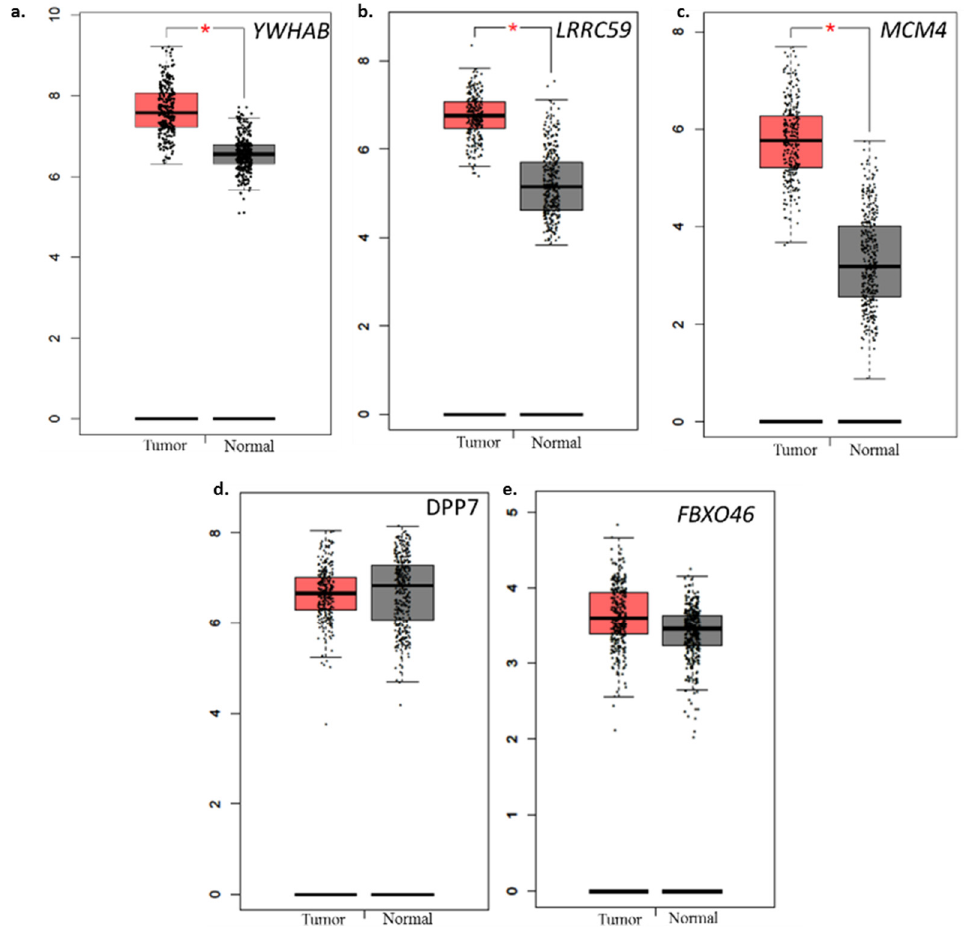
Figure 6. Differential expression of prognostic genes in cancerous tissue compared to normal. The expression of ( a ) YWHAB , ( b ) LRRC59 , ( c ) MCM4 , ( d ) DPP7 / 2 , ( e ) FBXO46 was assessed using normal tissue expression data from TCGA and GTEx dataset ( n = 349) and TCGA CRC tumor dataset ( n = 275). Higher expression of these genes except DPP7 / 2 and FBXO46 were significantly associated with tumors in CRC patients.